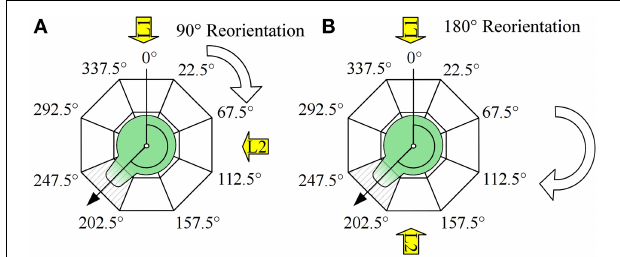
FIGURE 1 | Experimental design and scoring method and (A) 90 ◦ reorientation, (B) 180 ◦ reorientations. Angle between the vector pointing toward the first direction of the light (black line at 0 ◦ ) and the polarization vector (arrow, determined by the rhizoid outgrowth and the center of the cell) was scored by estimating its orientation on a angular scale with a 45 ◦ resolution as depicted (dashed interval). Numbers depict borders of the